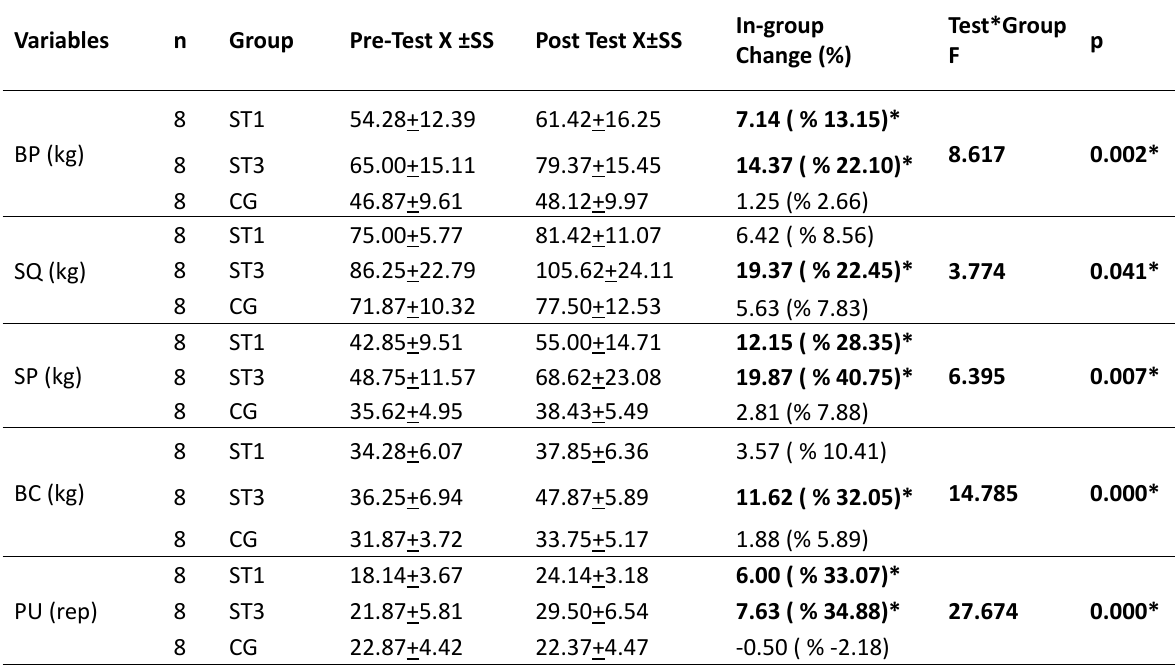
Table 4. Comparison of pre and post-test changes of dynamic strength tests among groups